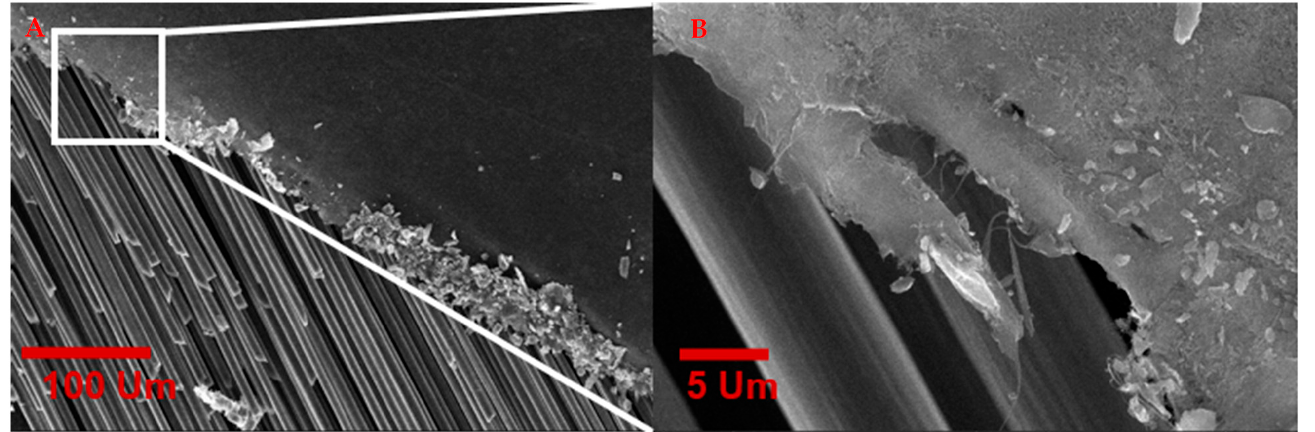
Figure 17. ( A , B ). SEM images of carbon fiber tows sandwich between CNT sheets produced from floating catalyst CVD method in a single-step integration method at two different magnifications